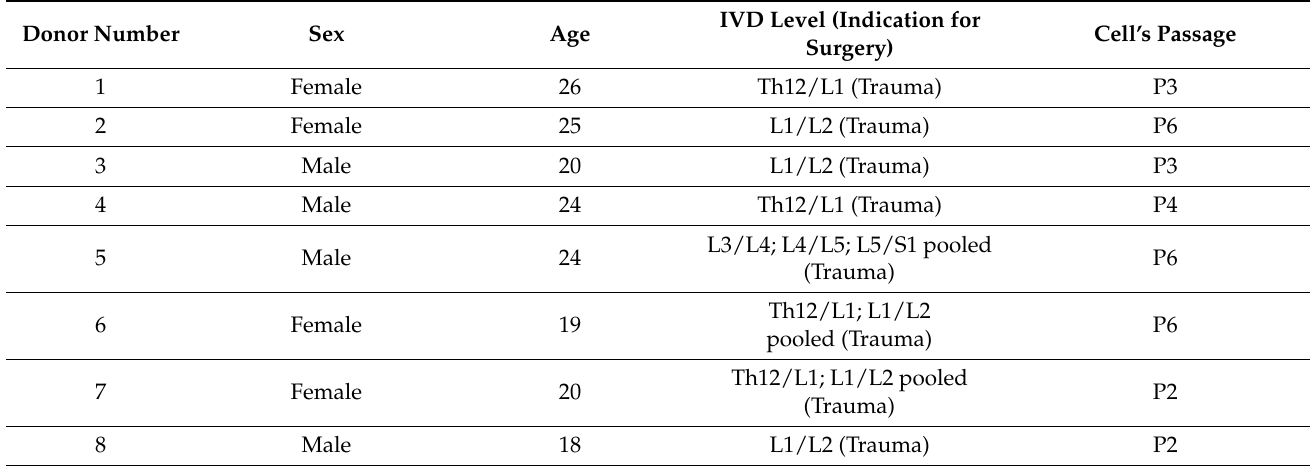
Table 1. Overview of the sex and age of the patient when the sample was collected, IVD tissue location, cell’s passage, and IVD status from all patients used in this project. Abbreviations: Th, thoracic; L, lumbar; S, sacrum; P, passage. Donor